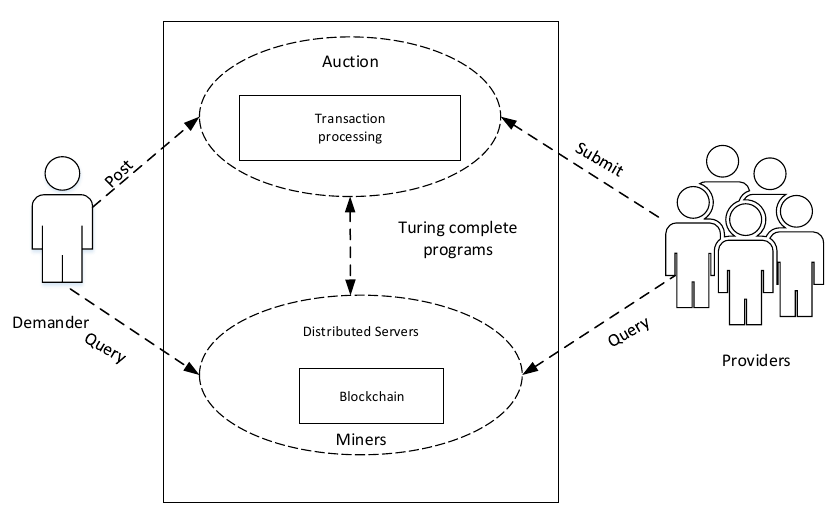
Figure 2. The model of cloud storage resource